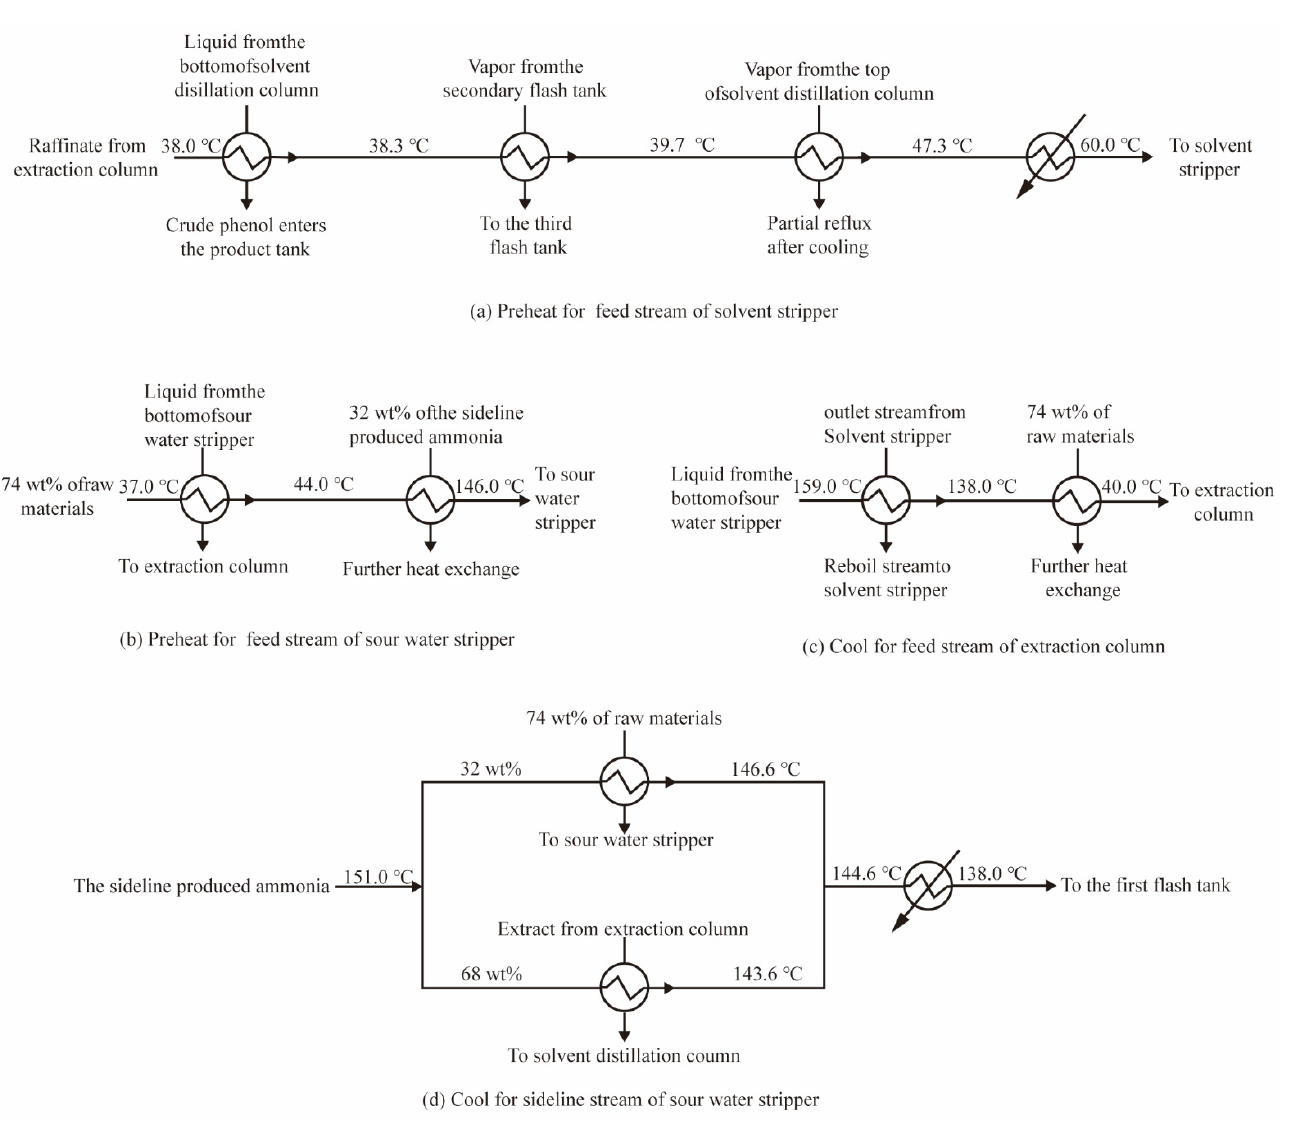
Figure 10. Schematic diagram of the stream direction in the heat exchange network. The arrow indicates the direction of heat transfer.